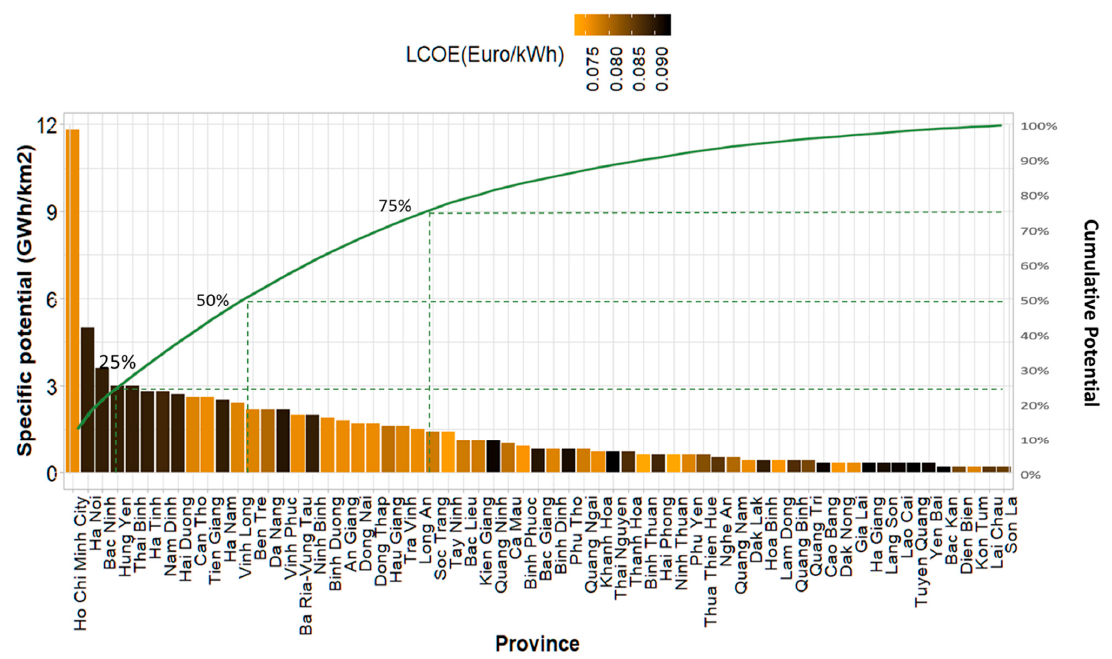
Figure 6. The electricity production potential (TWh/a) and average LCOE (Euro/kWh) at the discount rate 8% in 63 regions in descending order.